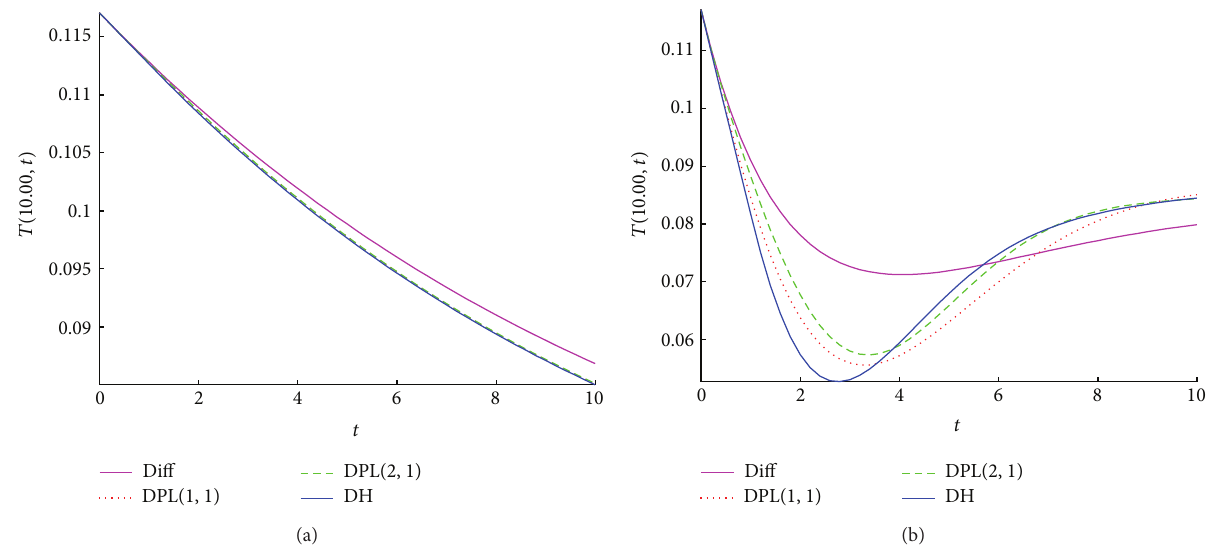
Figure 1: Temperature evolution, at 𝑥 = 10 , for DPL, DH, and classical diffusion (Diff) models with Dirichlet boundary conditions and parameters 𝜏 𝑇 = 0 , 𝜏 𝑞 = 1 , and initial function 𝜑(𝑥,𝑡) = 2(1 − cos (𝑥))/(𝜋𝑥) , for 𝛼 = 0.1 (a) and 𝛼 = 0.8 (b).